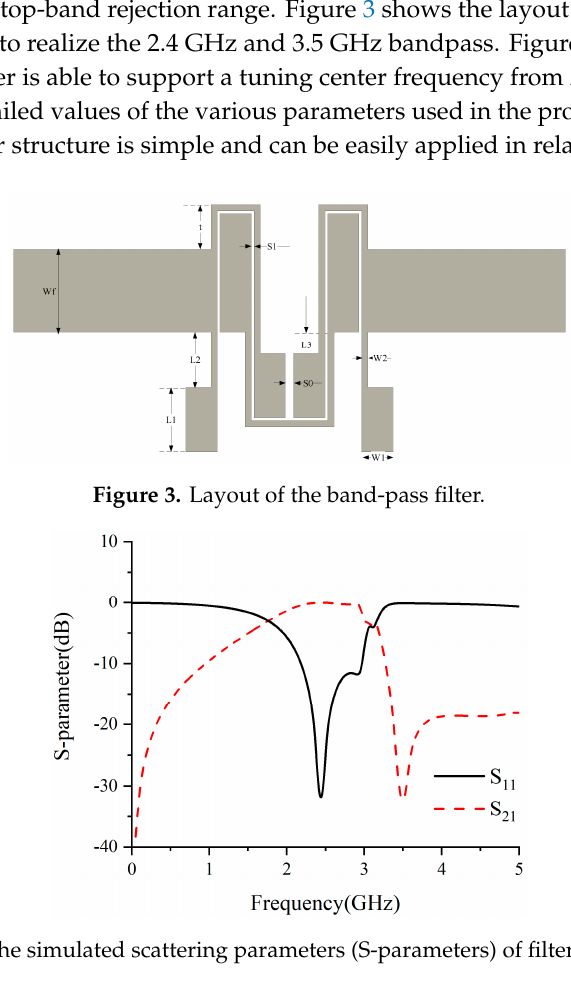
Figure 5. The simulated S-parameters of filter at 3.5 GHz. Table 2. Different parameters of the filter and their values at 2.4 GHz. Parameter 3 Table 3. Different parameters of the filter and their values at 3.5 GHz. Parameter